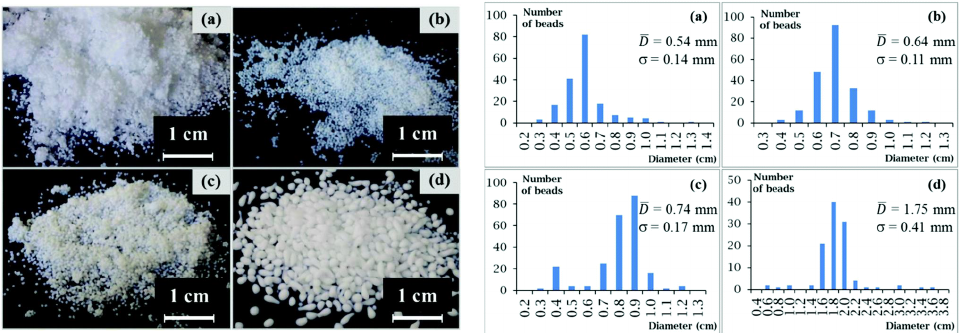
Figure 6. Photographs ( left ) and size distribution ( right ) of cellulose aerogel beads from 2% ( a – c ) and 3% ( d ) cellulose–[DBNH]CO 2 Et solutions coagulated in water ( a ), isopropanol ( b ), and ethanol ( c , d ) (reprinted with permission from [69]. Copyright © 2018, Royal Society of Chemistry).